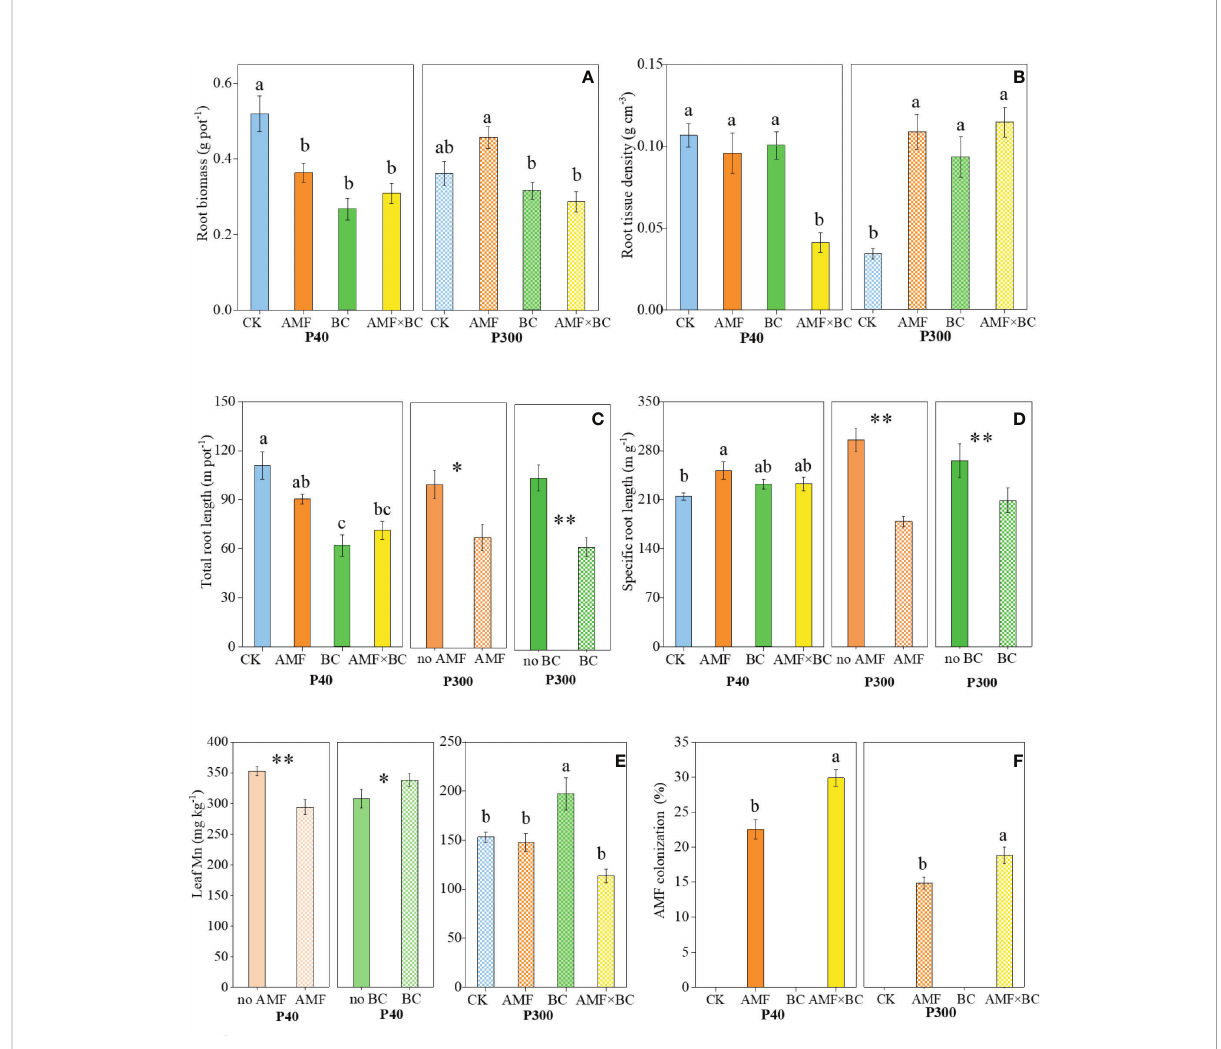
FIGURE 2 Variation in the root biomass and morphological traits (A) root biomass, (B) root tissue density, (C) total root length, (D) speci fi c root length, (E) leaf Mn concentrations, and (F) AMF colonization as in fl uenced by P rates (40 and 300 mg kg − 1 soil) and AMF and BC additions. Each value is the mean of fi ve replicates (±SE). For a given P rate, different letters in each graph denote signi fi cant difference among treatments ( P ≤ 0.05). * P ≤ 0.05 and ** P <